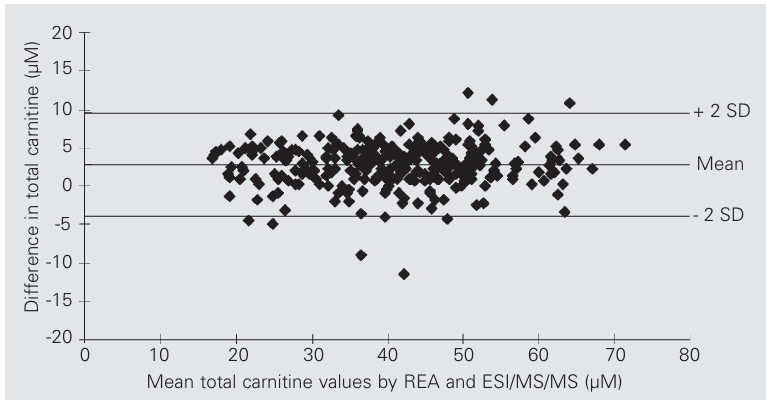
Figure 2. Bland-Altman plot of the difference, Vs, of the mean of paired values for total carnitine measurement comparing the radioenzymatic (REA) and ESI/MS/MS methods (N = 312, mean ± SD = 2.8 ±